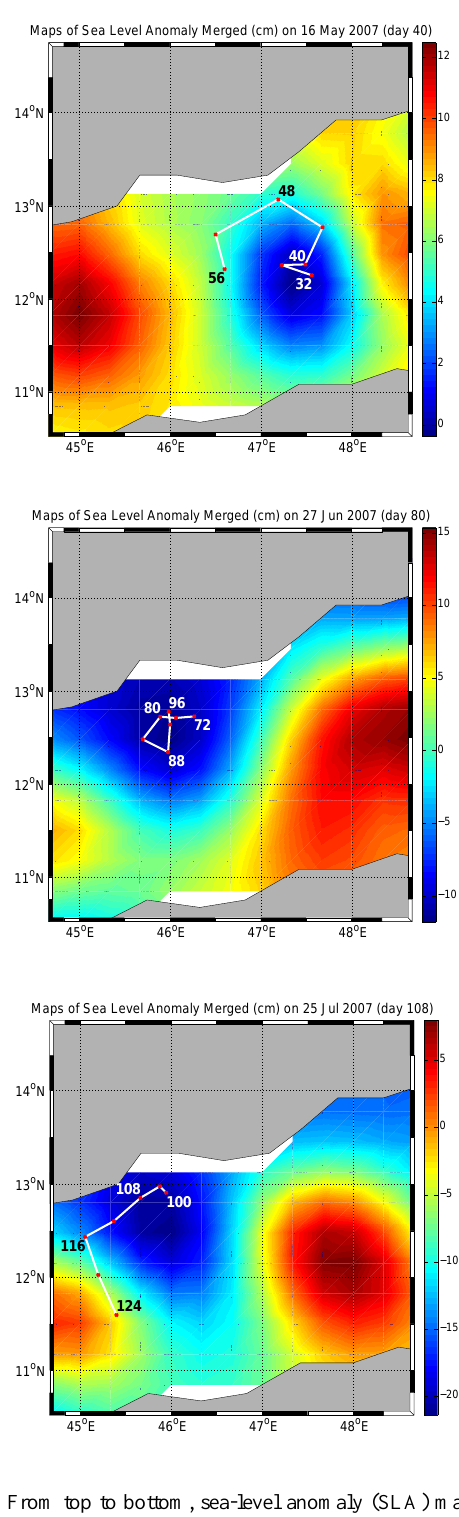
Fig. 4. From top to bottom, sea-level anomaly (SLA) maps of 16 Figure 4: Sea-level anomaly (SLA) map of May 16th and June 27th 2007 (days 40 and 80 of the mission - from top to bottom, previous page); SLA map of July 25th 2007 May, 27 June and 25 July 2007 (days 40, 80 and 108 of the mission). (day 108 of the mission - this page). The trajectory of float 1900432 is superimposed on The trajectory of float 1900432 is superimposed on each map. Red each map. Red dots correspond to the position of this float every 4 days; the number dots correspond to the position of this float every 4 days; the number close to the dots is the mission day shown only every 8 days for clarity. close to the dots is the mission day shown only every 8 days for